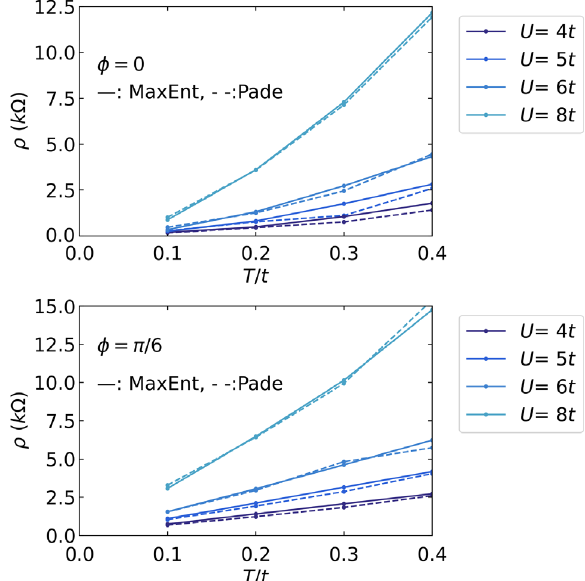
FIG. 11. Resistivity of the paramagnetic state for ϕ ¼ 0 ; π = 6 at half filling using analytical continuation MaxEnt (solid line) and Pad´e (dashed line)